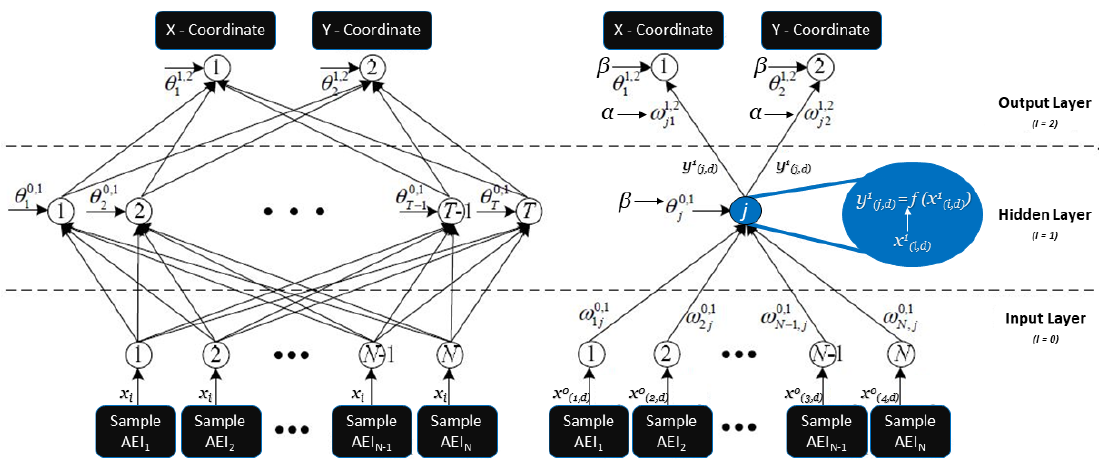
Figure 2. Topological mapping of Artificial Neural Network (ANN)-based mobility prediction for the London Underground and Overground (LUO)